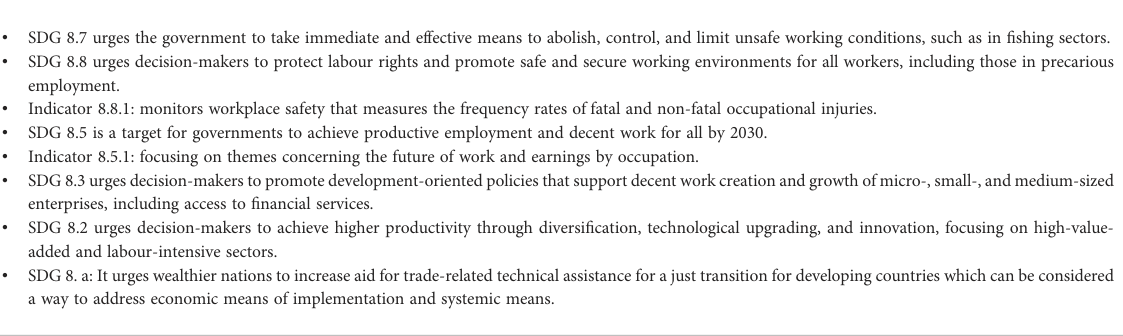
Box 1: Classi fi cation of SDG 8 targets adopted from the International Labour Organization decent work program and grouped for the dive fi sher labour force. (cid:129) SDG 8.7 urges the government to take immediate and effective means to abolish, control, and limit unsafe working conditions, such as in fi shing sectors. (cid:129) SDG 8.8 urges decision-makers to protect labour rights and promote safe and secure working environments for all workers, including those in